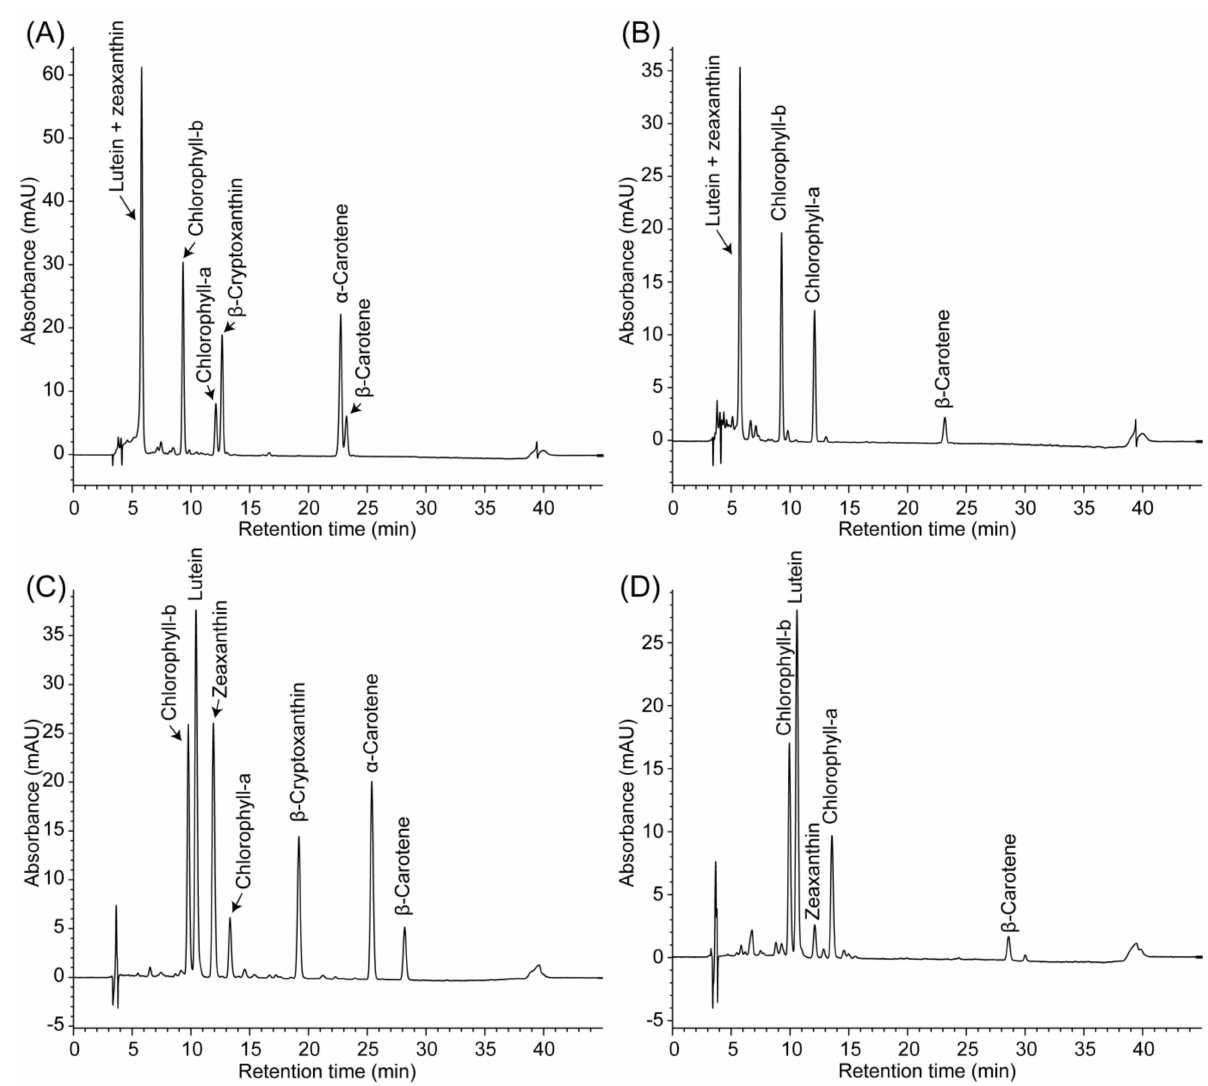
Figure 1. Chromatographic separation of carotenoids and chlorophylls for standard mixture and soybean seed sample by HPLC using C 18 and C 30 columns. ( A ) Standards by C 18 column; ( B ) soybean seed sample by C 18 column; ( C ) Standards by C 30 column; ( D ) soybean seed sample by C 30